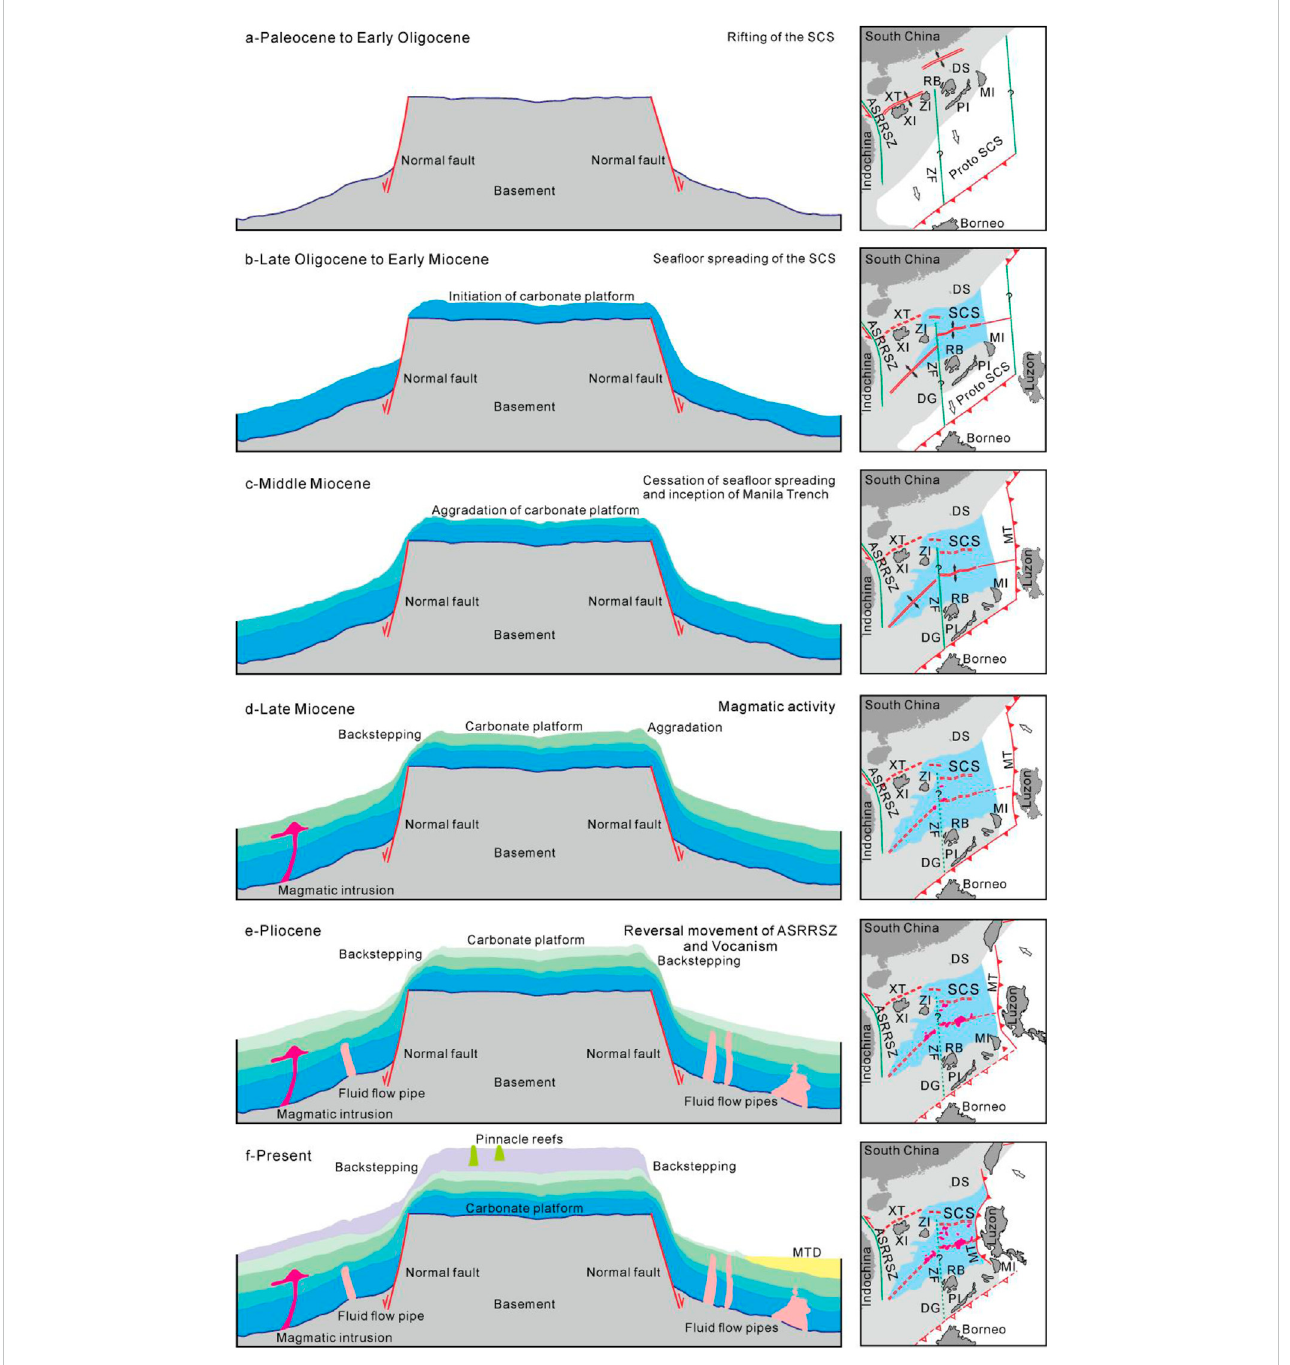
FIGURE 9 Sketchdiagramillustrating stratalgeometricpatterns andevolutionofYonglecarbonateplatform. (A) Thefaultedblockhasbeenformedbytherifting of the SCS during Paleocene to Early Oligocene. (B) The carbonate platform started to develop with sea fl oor spreading of the SCS from Late Oligocene to Early Miocene. (C) The carbonate platform continued growing with an aggradation pattern in Middle Miocene after the cessation of sea fl oor spreading of the SCS and inception ofManilaTrench. (D) The carbonateplatform started to backstep in leftsidewhereas rightside continued to aggradeduring Late Miocene when magmatism is very active in the SCS. (E) The carbonate platform fully backstepped and platform margins migrated toward the center during Pliocene correspondingtoreversalmovementofASRRSZandvocanismintheSCS. (F) Thecarbonateplatformcontinuedbacksteppingtoformthepresentshape.The evolutionary history of the SCS is modi fi ed from Li et al. (2015). SCS-South China Sea; MT-Manila Trench; ASRRSZ-Ailao Shan Red River Shear zone; ZF- Zhongnan Fault; DS-Dongsha Islands; XT-Xisha Trough; XI-Xisha Islands; ZI-Zhongsha Islands; DG-Dangerous (Nansha) Bank; RB-Reed (Liyue) Bank; PI- Palawan Island; MI-Mindoro